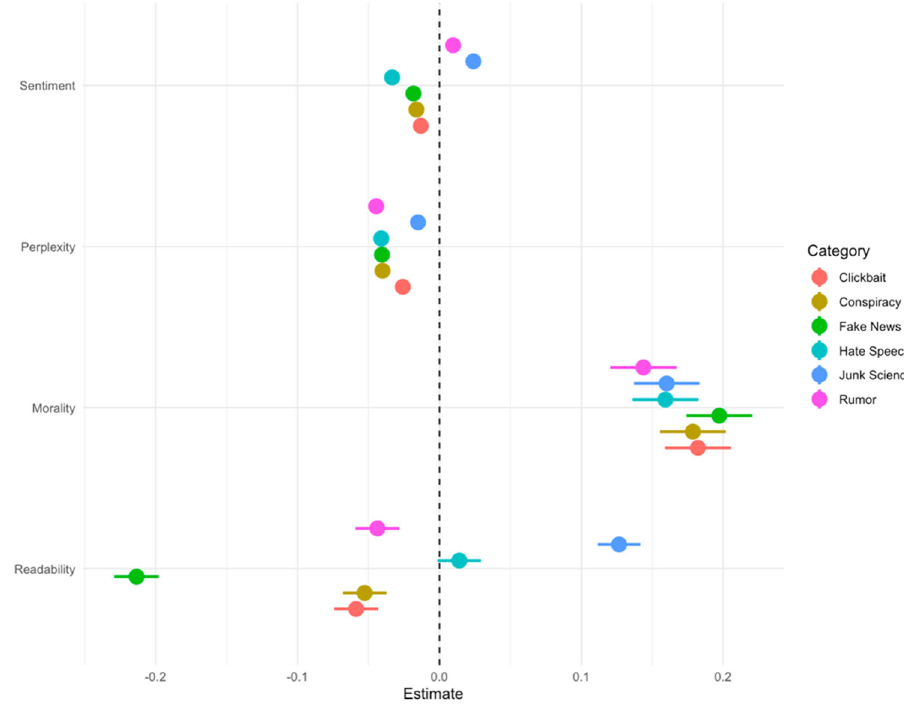
Fig. 4 Multinominal logistic regression results. Factual news are considered the level of the model output (i.e., the reference).